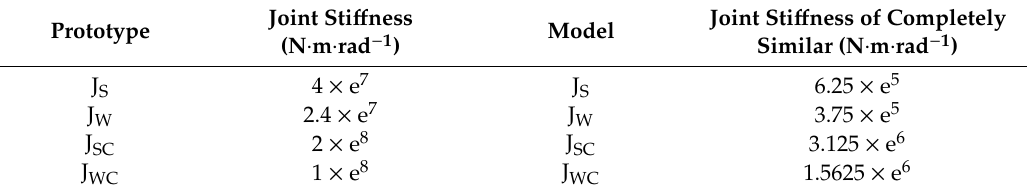
Table 4. Joint sti ff ness of completely similar.